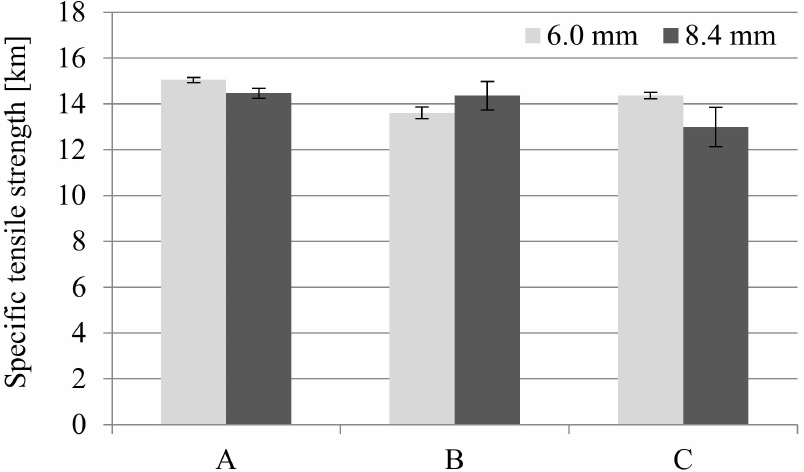
Figure 28. Influence of MuCell ® technology on specific tensile strength of all the PA66 GF30 samples, where A is a solid sample, while B and C are foamed at 16 and 20 MPa nitrogen pressure